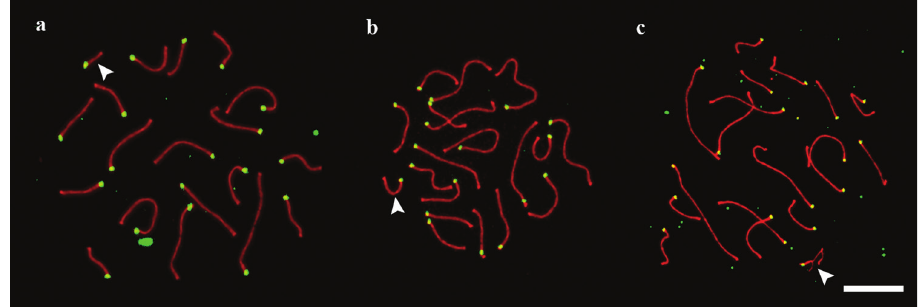
Figure 1. SC spreads of sand lizards. a standard karyotype b homozygote for the long variant of SC 19 c heterozygote for the long variant of SC 19. Arrowheads indicate SC 19. Red: SYCP3. Green: ACA. Scale bar: 10